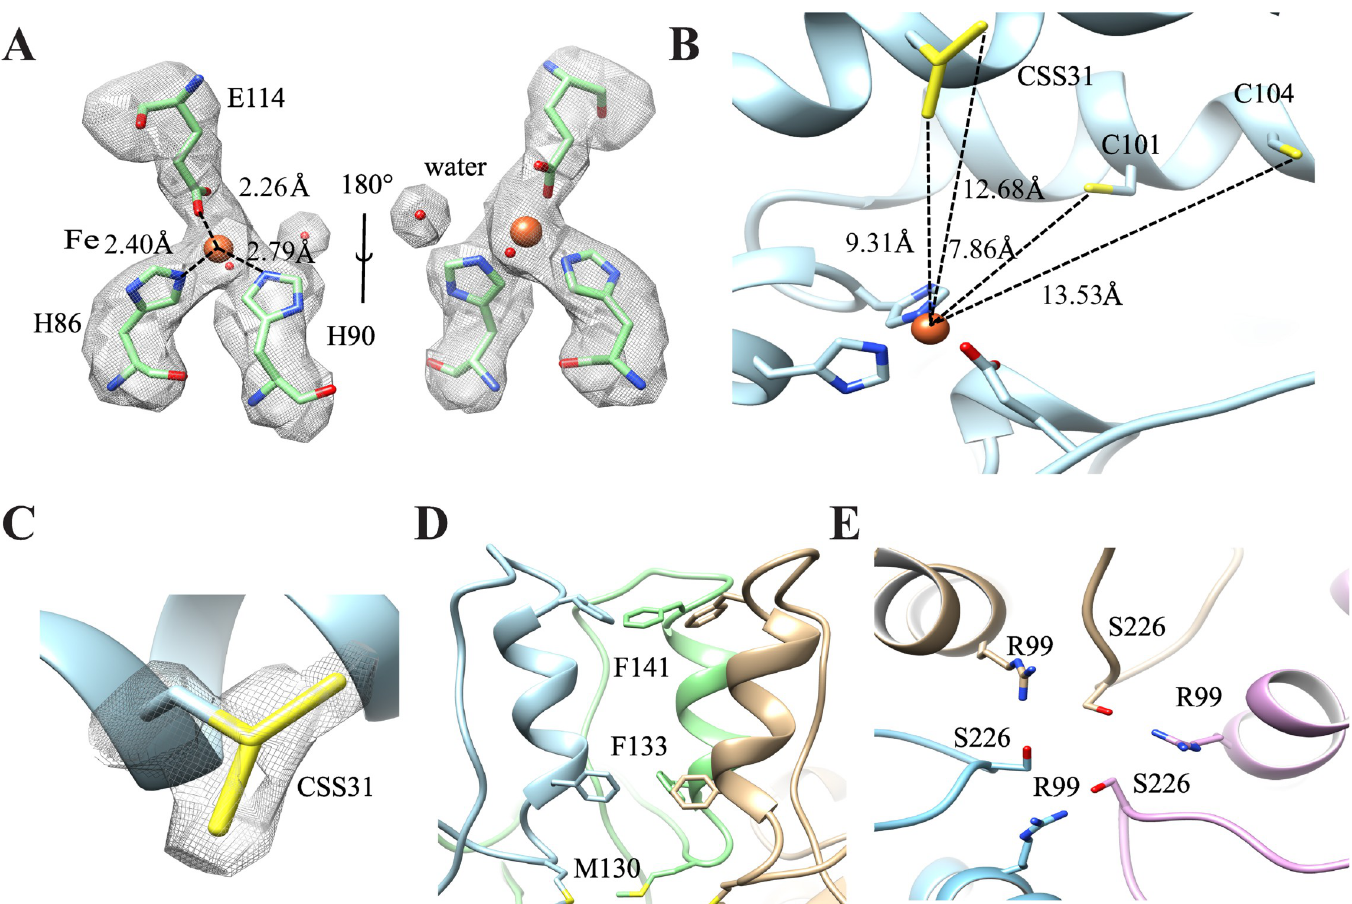
Fig 3. The catalytic pocket of SOR. ( A ) The mononuclear nonheme iron center in the active-site contains Fe 3+ ion (orange sphere) ligated to the three conserved residues H86, H90 and E114. The distances between Fe 3+ ion and the three nearby side chains are denoted. The catalytic site contains two water molecules (red spheres) that could be identified from the cryo-EM map as previously observed in the x-ray crystal structure [21]. A 180˚ view of the same region is shown. ( B ) Fe 3+ is hexa-coordinated to three conserved cysteines and the H86, H90 and E114 residues. The distances between Fe 3+ ion and the three conserved cysteines; pursulfurated cysteine 31 (CSS31), C101 and C104 are denoted. ( C ) The enlarged region shows extra density in the cryo-EM map due to the existence of CSS31 in two rotamer conformations with equal occupancies. ( D ) Side view of the channel formed at the 4-fold symmetry axis, where only three monomers are depicted for clarity. The outer, inner and bottom rings are formed by F141, F133, and M130, respectively. ( E ) Top view of the channel formed at the three-fold axis by R99 and S226 residues. The hydrophilic trimer channels are formed by three subunits positioned along a 3-fold symmetry axis and are proposed to be the exit routes of the polar products such as HSO 3 − , HS − and S 2 O 32 − .